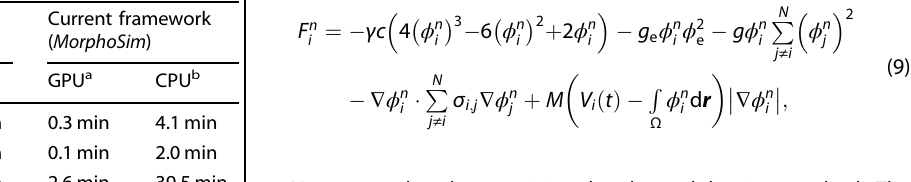
Table 1. Computing time in GPU and CPU using the previous and current